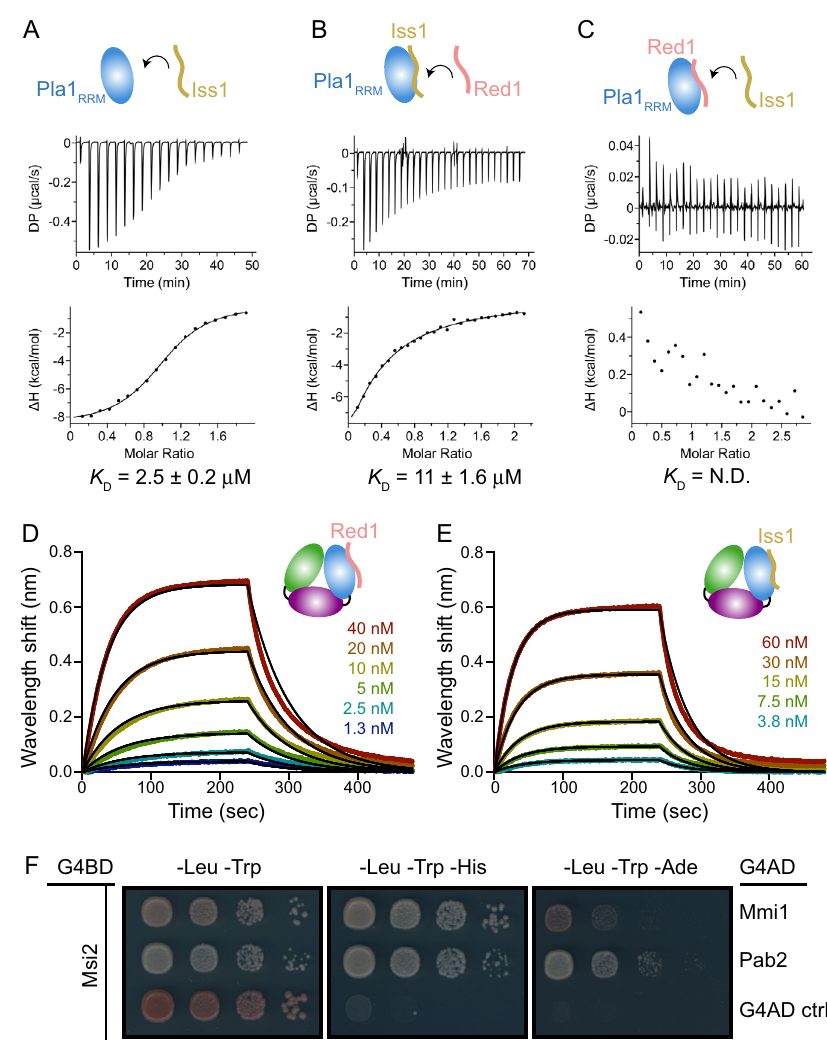
Fig. 6 | InteractionsbetweenMTREC andCPF. A ITCtitration of Iss1 intoPla1 RRM . B ITC titration of Red1 288-345 into a pre-formed complex of Pla1 RRM -Iss1 30-76 . C ITC titration of Iss1 into a pre-formed complex of Pla1 RRM -Red1 288-345 . The calculated dissociationconstants( K D )fromanaverageoftwoindependentmeasurementsare shown. BLI kinetic analyses of biotinylated Red1 288-345 and Iss1 30-76 with varying